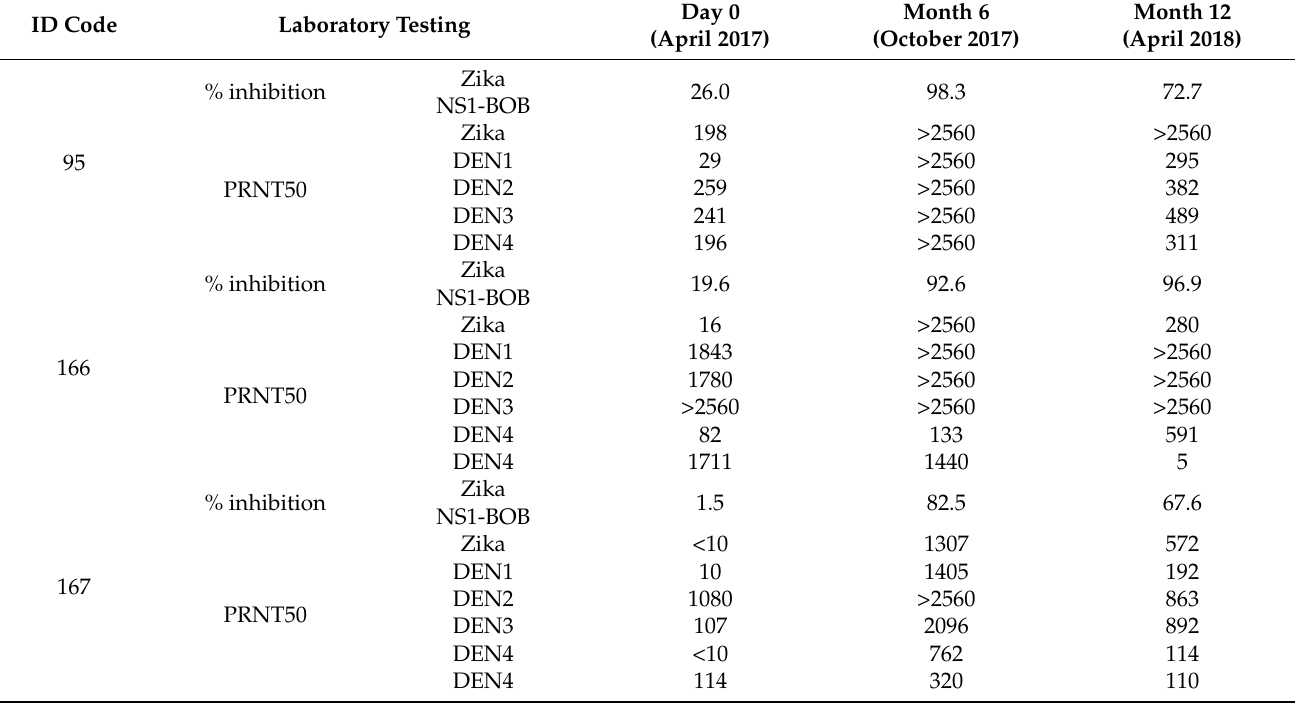
Figure 3. The change in the serostatus of the participants at each visit. The orange color represents the proportion of seroconverted participants between Day 0 and Month 6. The green color represents subjects with seroconversion between Month 6 and Month 12 (N/A: participants lost to follow-up). Table 3. The results of the Zika virus nonstructural protein 1 (NS1) blockade-of-binding (BOB) ELISA and the neutralizing antibodies against Zika virus and dengue virus serotypes detected by PRNT50 among the 12 participants with definite seroconversion.